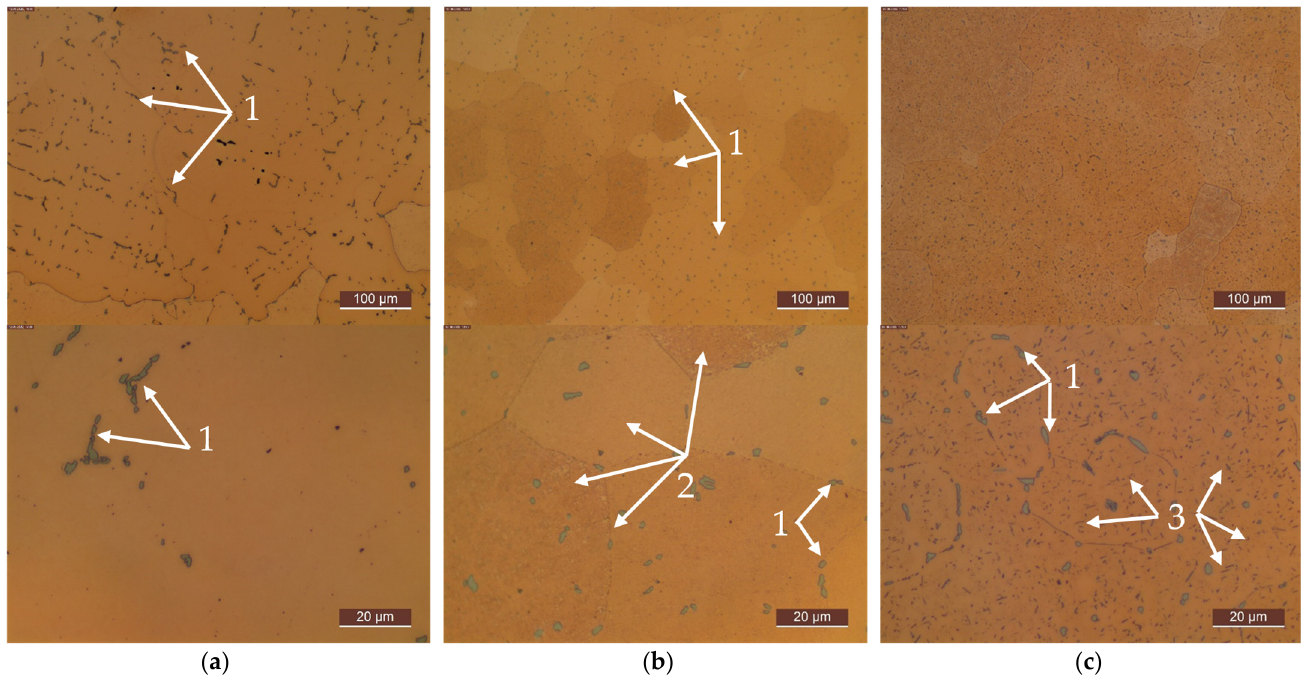
Figure A9. Microstructure evolution of CuHf0.7 during DSC measurements in the optical microscope: specimen without cold rolling; ( a ) initial state; and after DSC measurement; ( b ) condition 1; ( c ) condition 2; showing undissolved hafnium phases after casting (1), homogenously distributed fine precipitates (2), and coarsened hafnium precipitates (3).